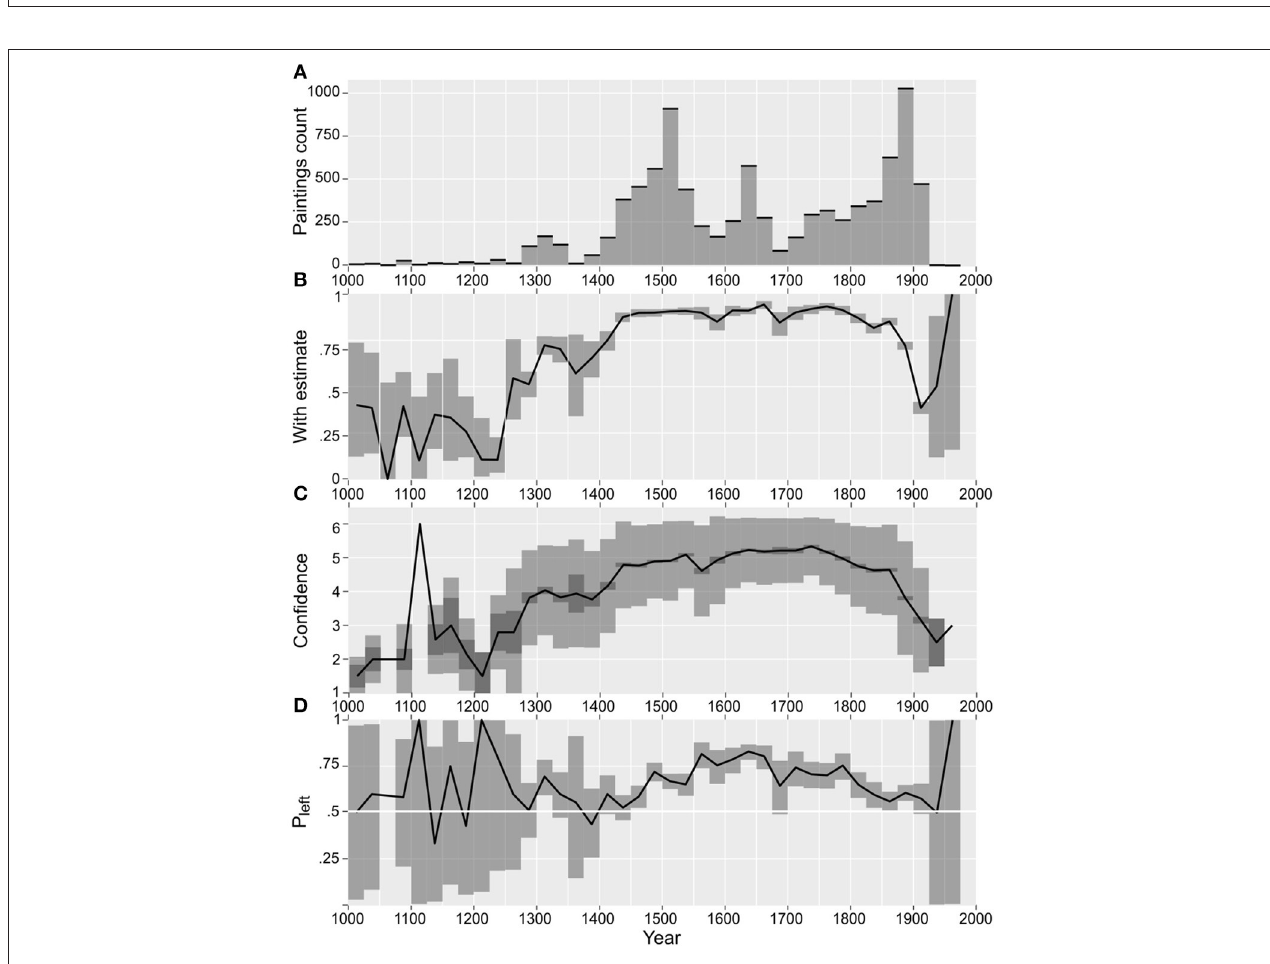
FIGURE 5 | Light source Zeitgeist. (A) Distribution of paintings’ creation date. Please note that paintings created before 1000A.D. are not shown. (B) The proportion of paintings for which an estimate was possible. (C) Participants’ confidence, lighter and darker gray stripe denote, respectively, standard deviation and standard error of the mean. (D) The proportion of the light source direction estimated as originating from the left. Gray stripe denotes 99% binomial confidence interval.